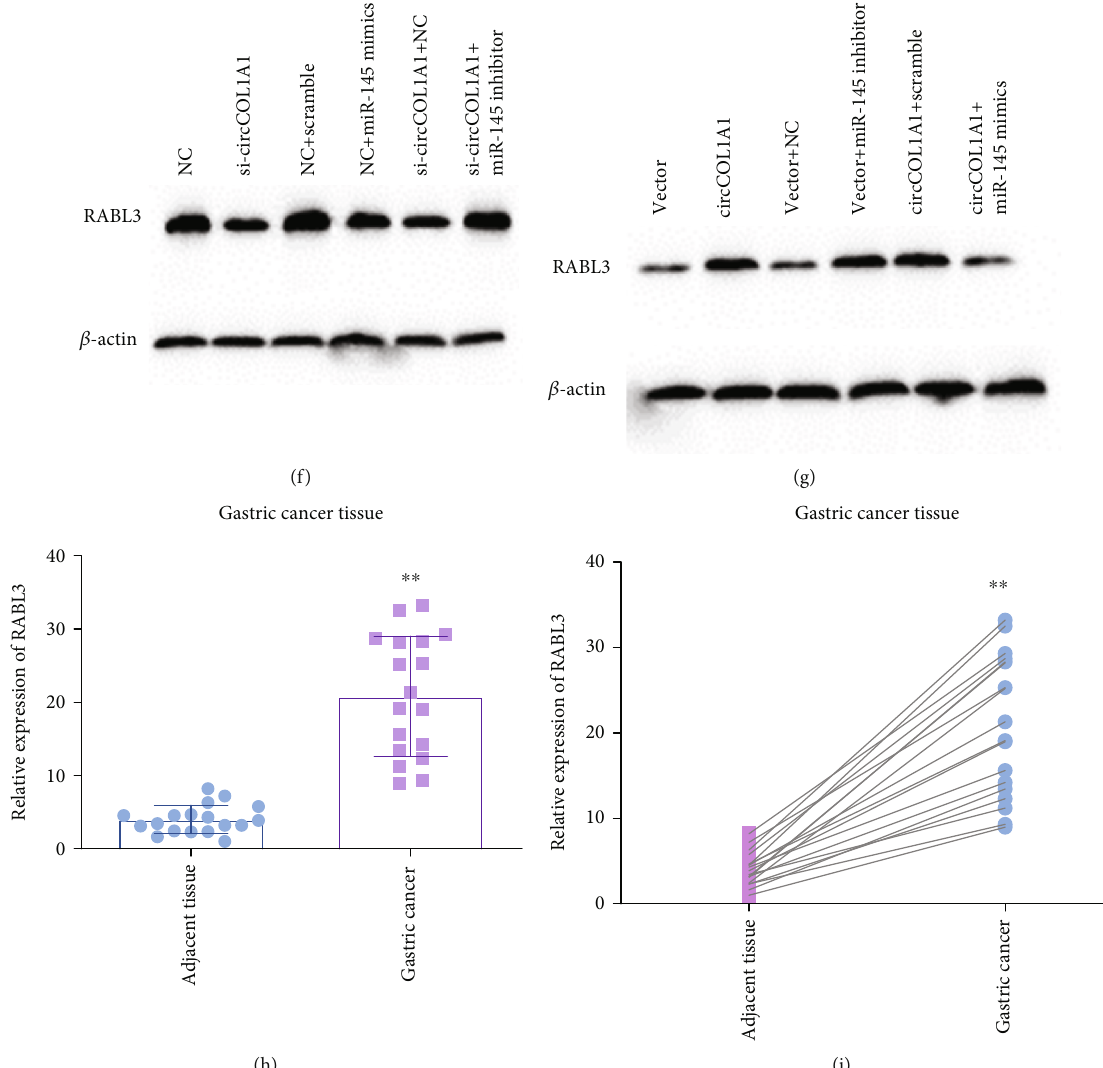
Figure 5: RABL3 is the target of miR-145 and regulated by circCOL1A1. (a) StarBase V3.0 predicted that RABL3 was the target gene of miR-145. The binding site was shown as indicated. (b) Luciferase reporter assays were performed in AGS transfected with wild type and mutant miR-145. (c) Luciferase reporter assays were performed in MKN-45 transfected with wild type and mutant miR-145. (d) Relative expression of RABL3 mRNA in NC and circCOL1A1 silenced AGS cells which were transfected with miR-145 mimics or inhibitors. (e) Relative expression of RABL3 mRNA in Vector and circCOL1A1 overexpressing MKN-45 cells which were transfected with miR-145 inhibitors or mimics. (f) Protein level of RABL3 was identi fi ed by western blot in AGS cell line. (g) Protein level of RABL3 was identi fi ed by western blot in the MKN-45 cell line. (h, i) RABL3 level was identi fi ed in gastric cancer